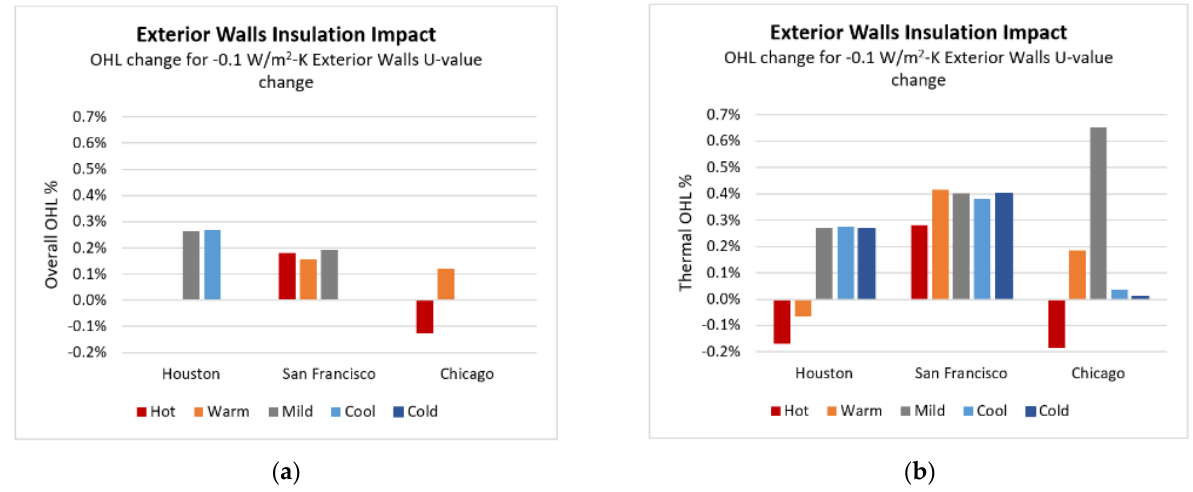
Figure 9. Impact of a 0.2 W/m 2 -K decrease in window U-value on overall ( a ) and thermal ( b ) OHL.